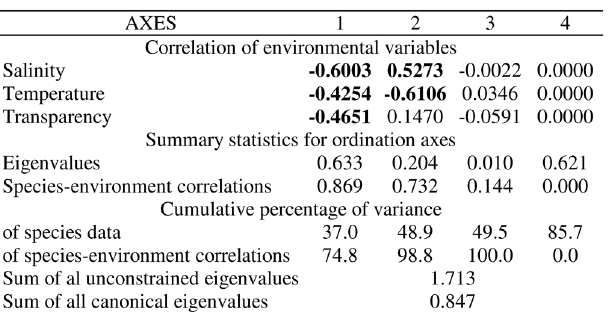
Table 6. Summary of the CCA performed on the abundance of adults species of Engraulidae family. Significant environ - mental variables were selected by a stepwise procedure analo- gous to forward elimination in multiple regression analysis. Significant values (p<0.05) in